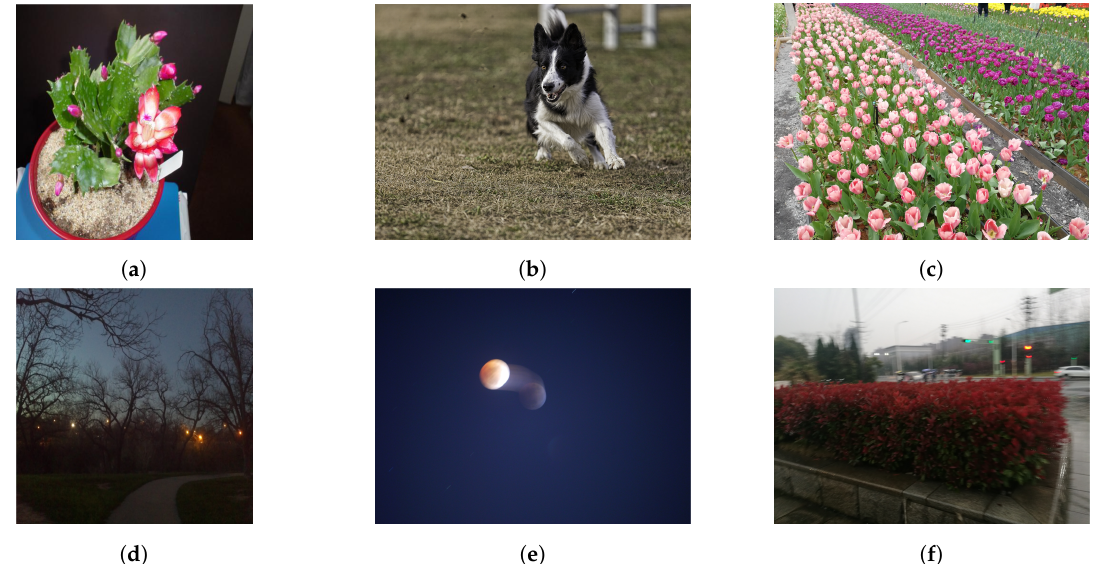
Figure 6. Sample images form the three Image Quality Assessment (IQA) databases: ( a ) and ( d ) images from the LIVE-itW with a MOS of 78.81 and 43.67 respectively, ( b ) and ( e ) KONIQ’s pictures with a MOS of 71.46 and 43.36; finally ( c ) and ( f ) photos form SPAQ whit a MOS of 75.43 and 33.0